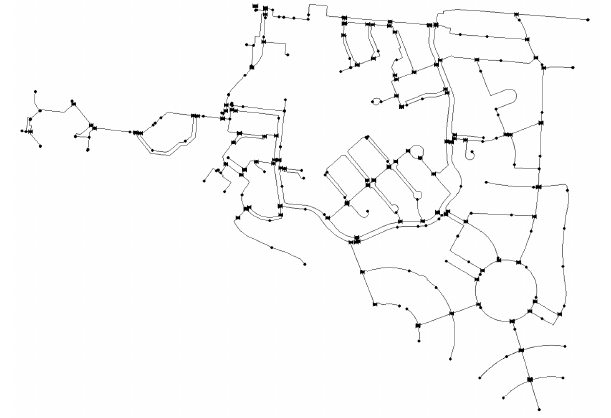
Figure 1. EPANET model of the drinking water distribution net- work of Sittard (Netherlands), consisting of 583 junctions, 491 pipes, 140 valves and 1 reservoir.